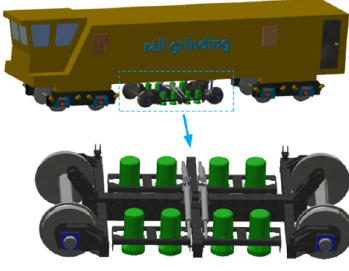
Figure 1. Rail grinder.